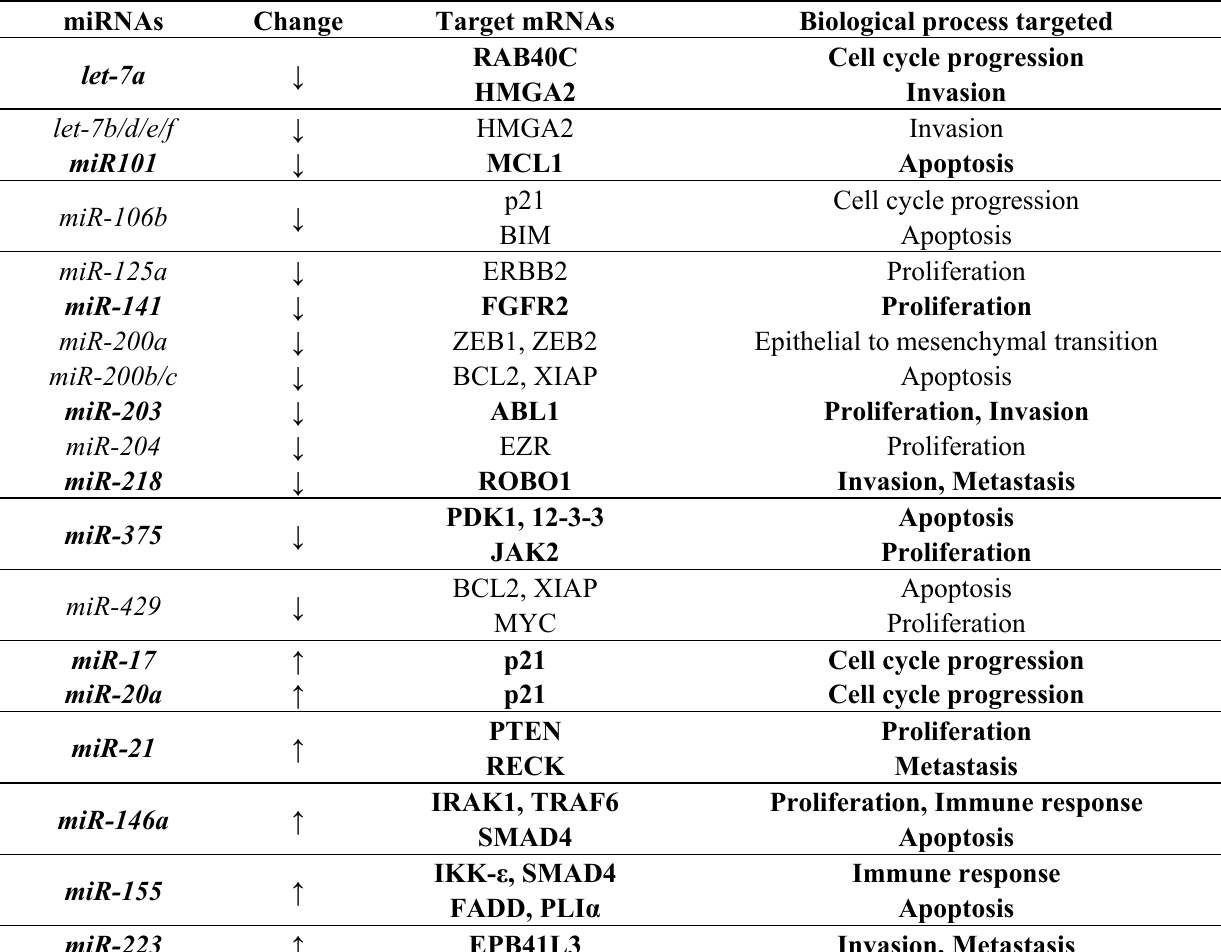
Table 1. MicroRNAs (miRNAs) change in response to Helicobacter